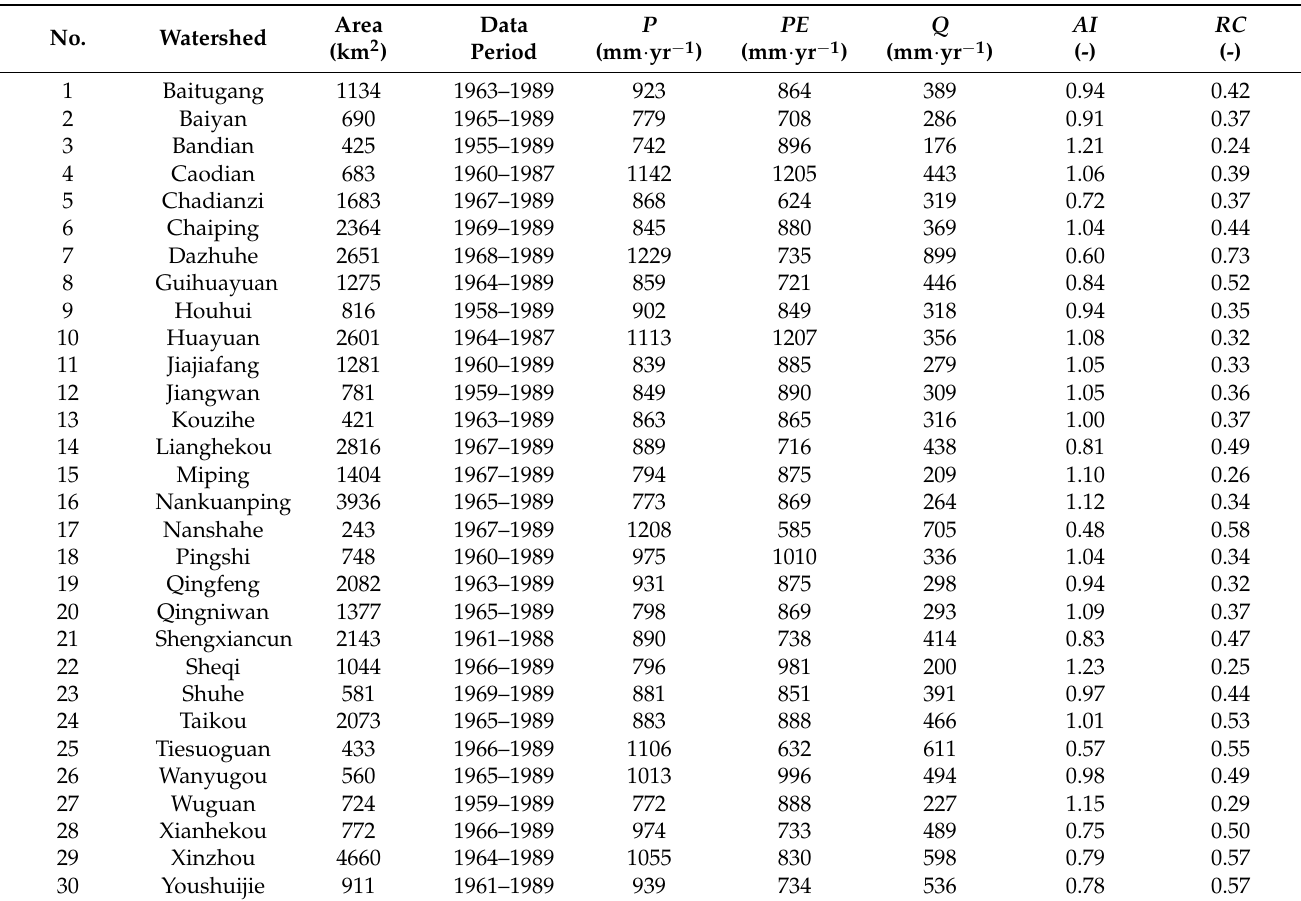
Table 1. Data information for the studied